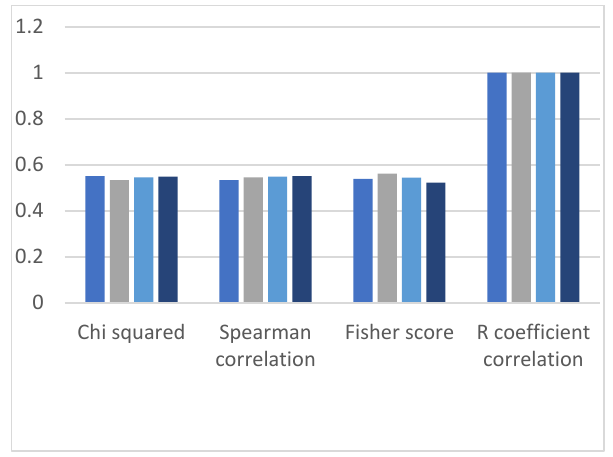
Figure 8. Precision using enhanced SVM.